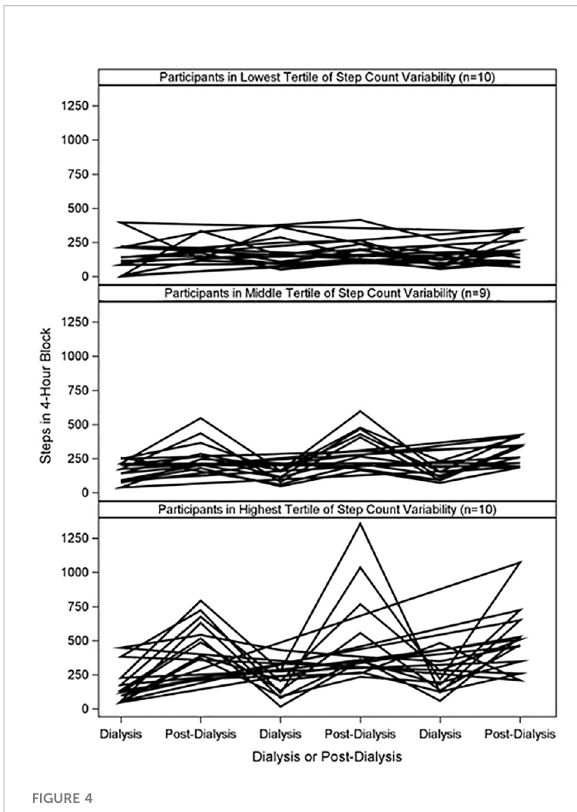
FIGURE 4 Individual Step Counts at Dialysis and Post-Dialysis Blocks by Tertile of Step Count Variability. Participants were grouped into tertiles of step count variability. Plot shows step counts at dialysis and post-dialysis 4-hour blocks from three distinct dialysis